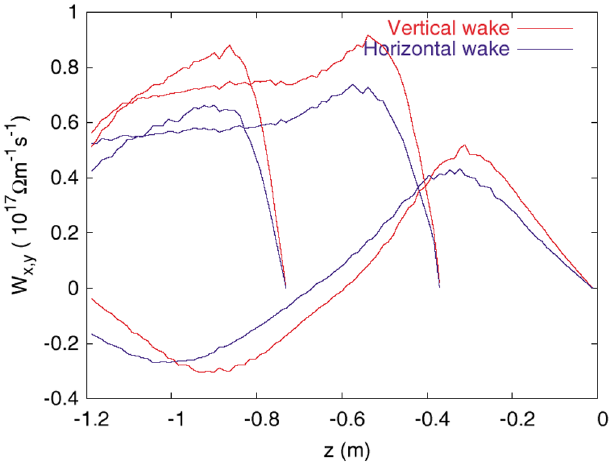
FIG. 70. (Color) Horizontal and vertical dipole wake functions for a uniform SPS bunch obtained by displacing several bunch slices in a field-free region and averaging the resulting forces over the transverse beam size [85]. butions shown in Fig. 72 were generated by Rumolo as initial input densities for single-bunch wakefield calcula- tions. Wakefields corresponding to the different horizontal positions of the two stripes in Fig. 72 are illustrated in Fig. 73. For the same average density of electrons, the amplitude of the vertical wake is greatly reduced as the electron stripes move away from the vicinity of the beam.